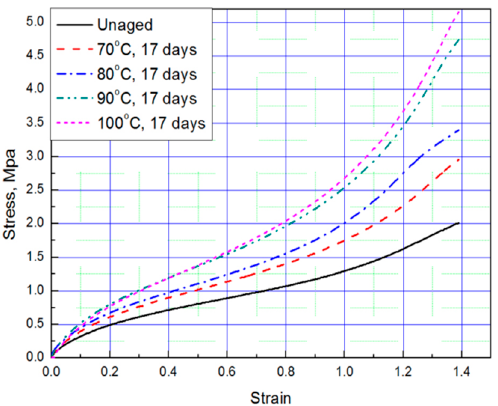
Figure 2. Tensile curves according to aging temperature (Strain: 1.39).